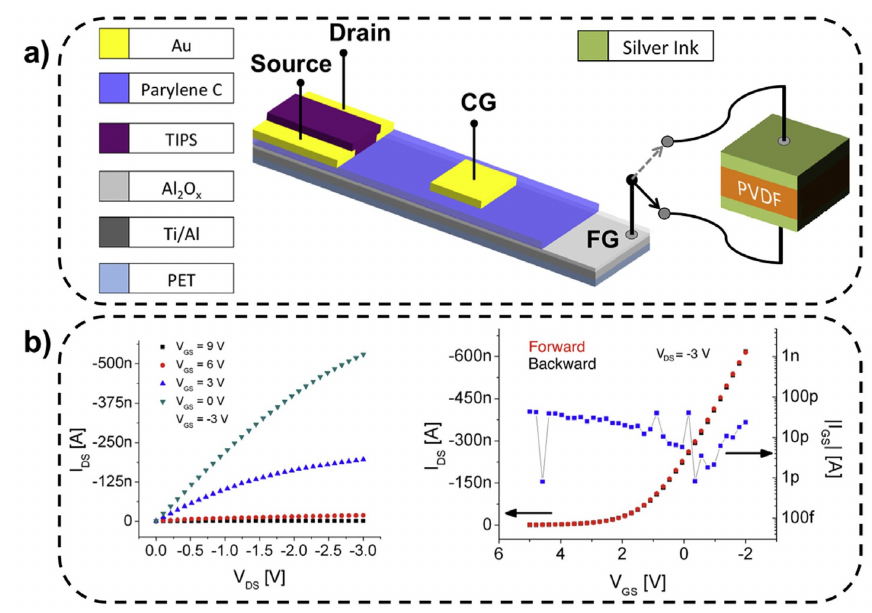
Figure 9. ( a ) Structural details of organic charge modulated FET (OCMFET) coupled to PVDF capacitor. ( b ) Output and input characteristics of OCMFET device for tactile sensing; Reprinted with permission from [87] c (cid:13) 2016 Elsevier.